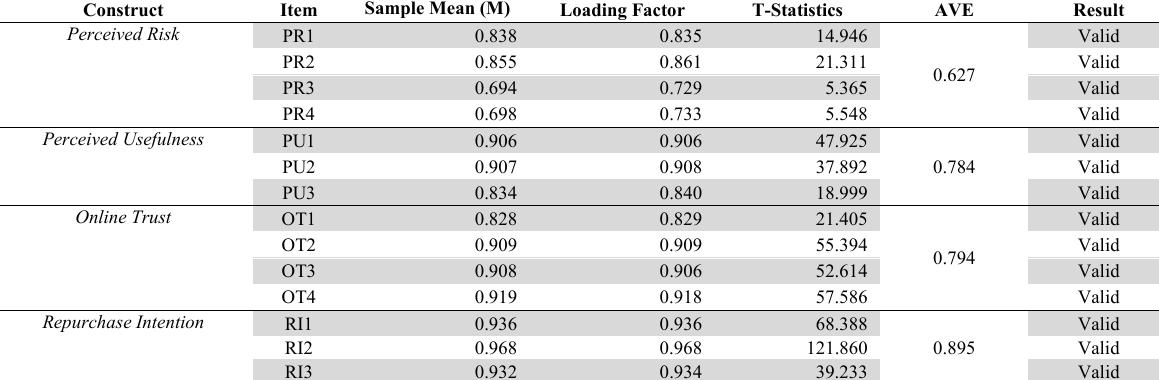
Convergent validity and Average Variance Extracted